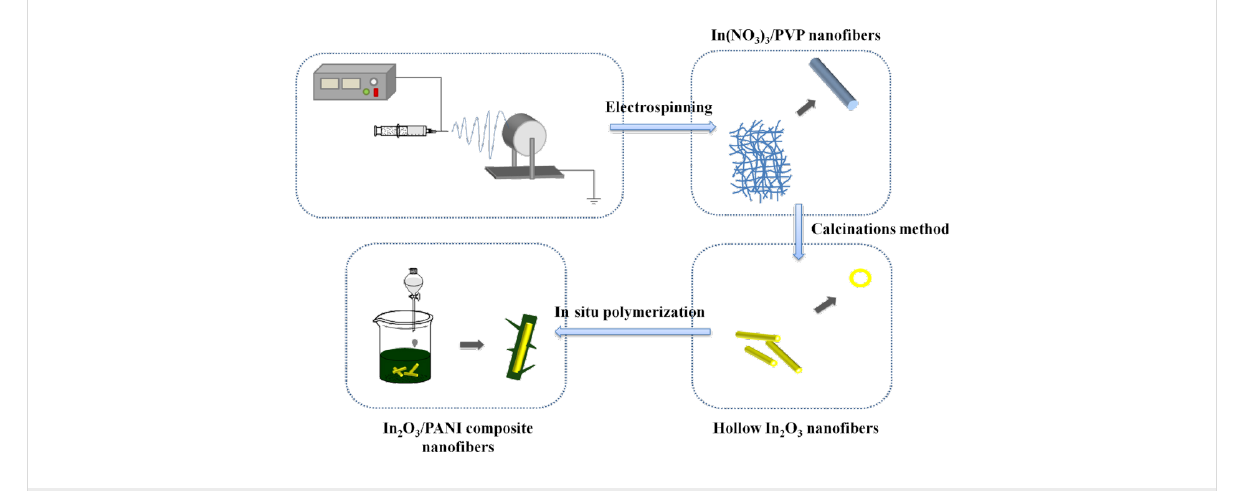
Figure 1: Schematic of the preparation of In 2 O 3 /PANI composite nanofibers.